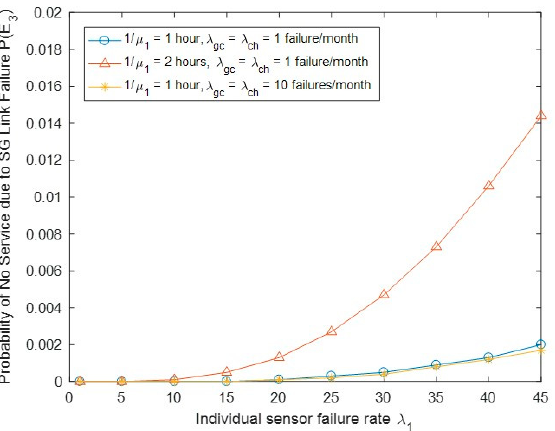
Figure 8. Probability of no service due to SG link failure P ( E 3 ) vs. biosensor failure rate λ 1 .